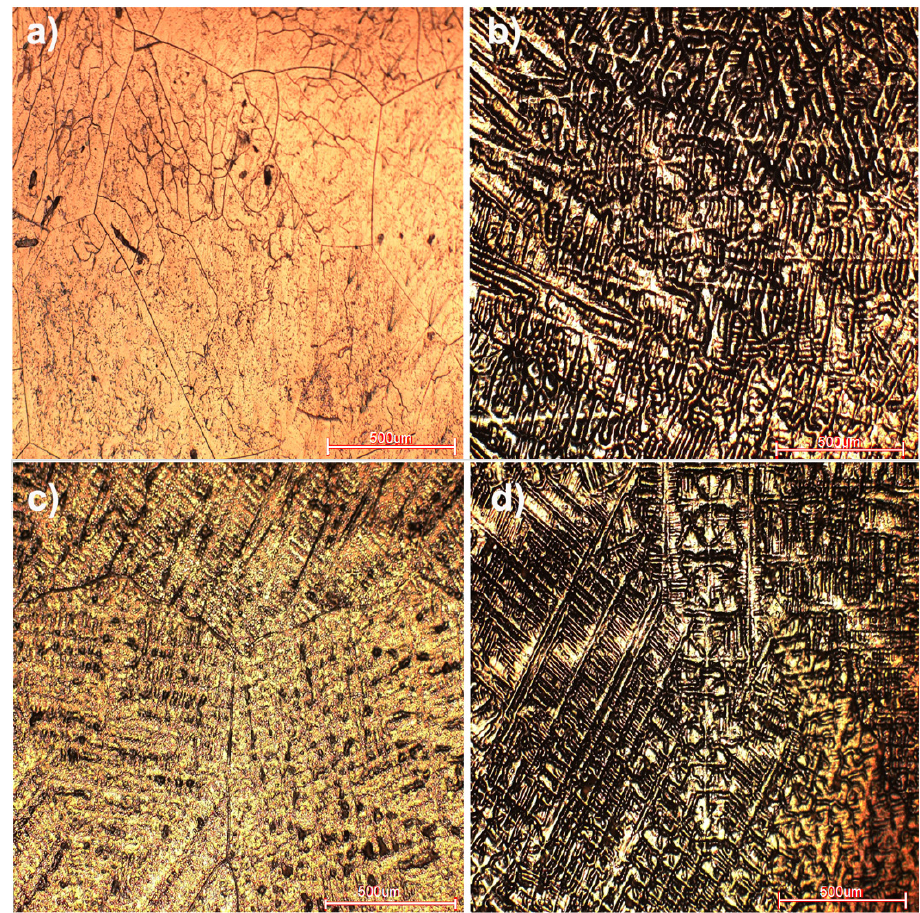
Figure 3. Light microscopy images of substrate materials: ( a ) S1; ( b ) S2; ( c ) S3; ( d ) S4.